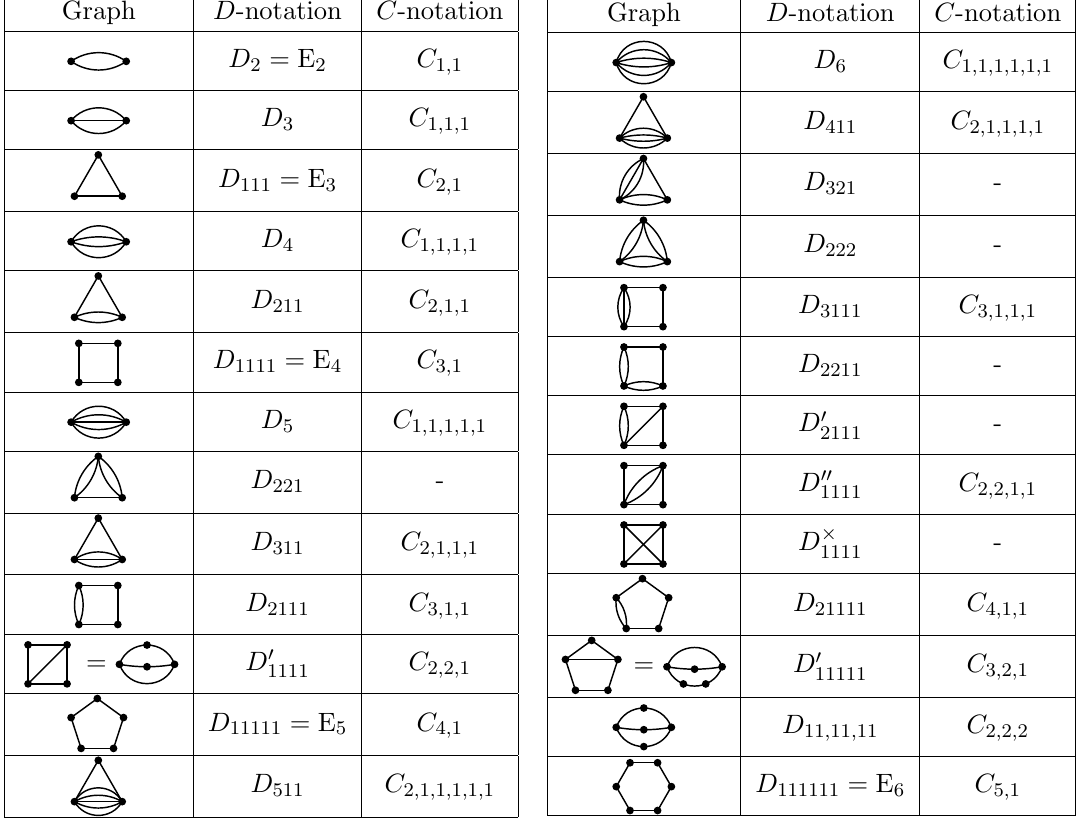
Table 1 . Di(cid:11)erent notations for modular graph functions in various